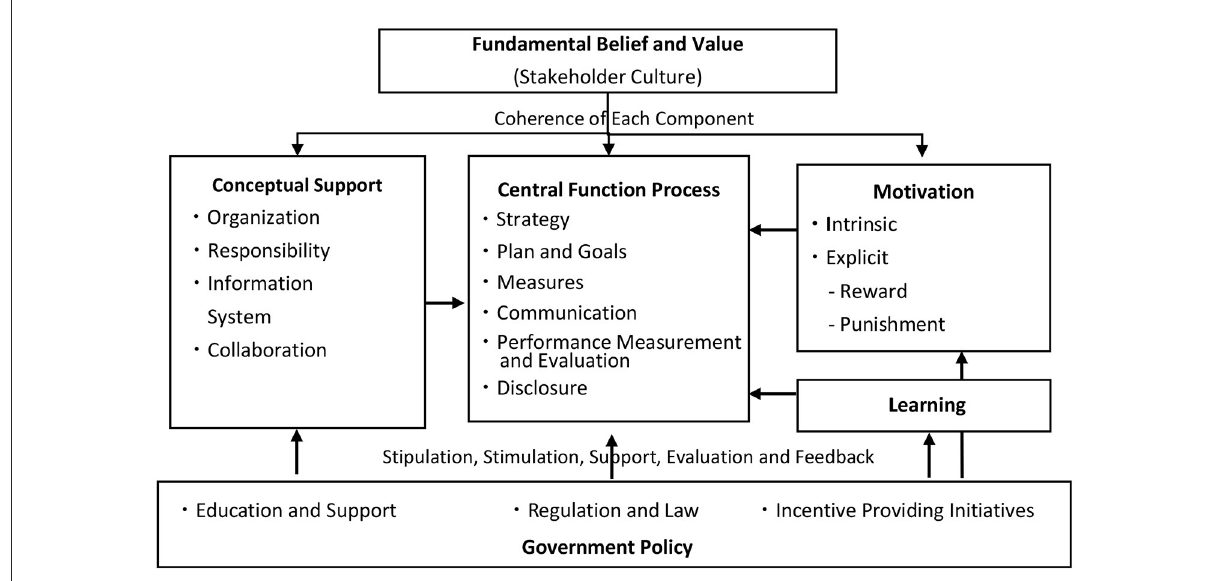
FIGURE12 The government-led H&PM